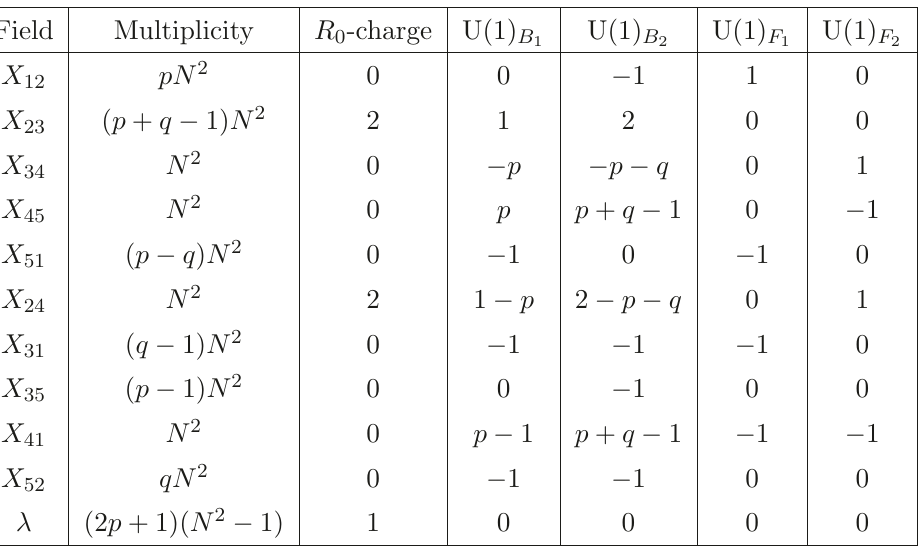
Table 2 . The field content of the X p,q quiver